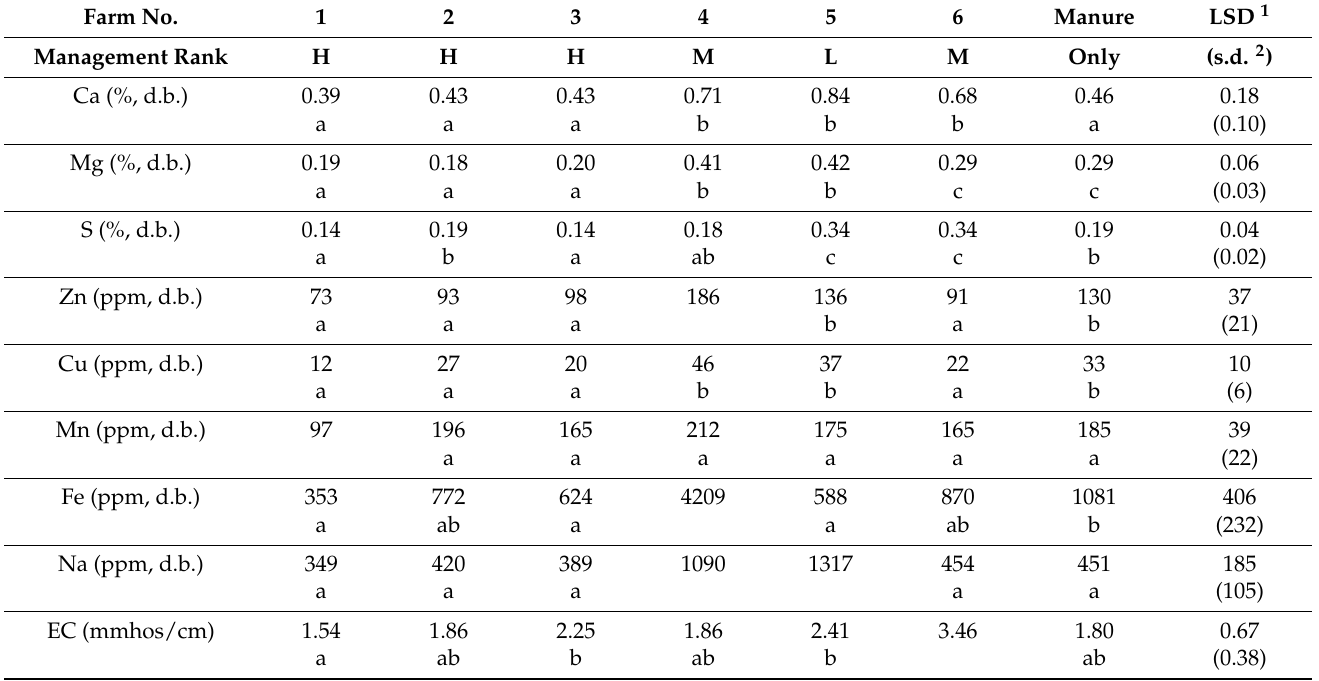
Table 3. Electrical conductivity and minor plant nutrient concentrations in horse manure. Treatment means with the same letter below were not significantly different. Comparisons were made across the